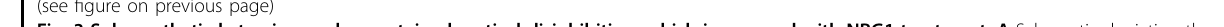
10 − 20 . Two-sample t test (adjusted for multiple compar- isons): in vivo ketamine vs saline, 1 h p = 5.01 × 10 − 9 , 24 h p = 8.54 × 10 − 8 , 48 h p = 1.69 × 10 − 8 , 72 h p = 1.04 ×